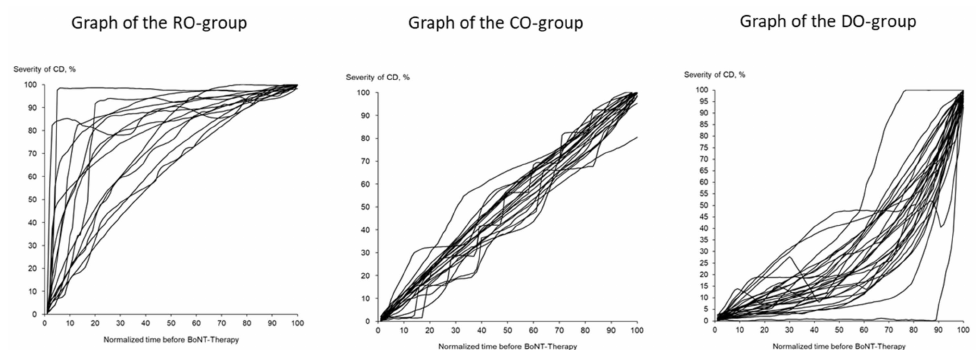
Figure 1. Depending on the curvature, three different main types of course of disease graphs (CoD) could be distinguished. On the left side, all graphs with a rapid onset CoD ( n = 16) are presented, in the middle, all graphs with a continuous worsening are presented ( n = 23), and on the right side, all graphs with a low worsening in the beginning ( n = 30) are